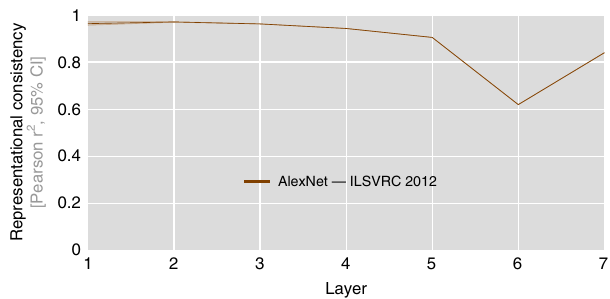
Fig. 6 Representational consistency decreases in AlexNet. We repeated our above analyses of representational consistency on a set of AlexNet instances trained on large-scale object classi fi cation data set ILSVRC 2012. Again, we only vary the initial random seed of the network weights. In line with our previous results, we observe a decrease in representational consistency from early to late network layers. The minimal average consistency is observed in layer fc6, which exhibits 62% of the shared variance across network RDMs. As AlexNet requires the input of size 224 × 224, which is signi fi cantly larger than the 32 × 32 image size of CIFAR-10 used earlier, we created an independent set of larger images from the same 10 categories while following the same data set structure (100 images per CIFAR-10 category). Ten network instances correspond to 45 pairwise distance estimates per network layer, average representational consistency shown here with 95% con fi dence intervals